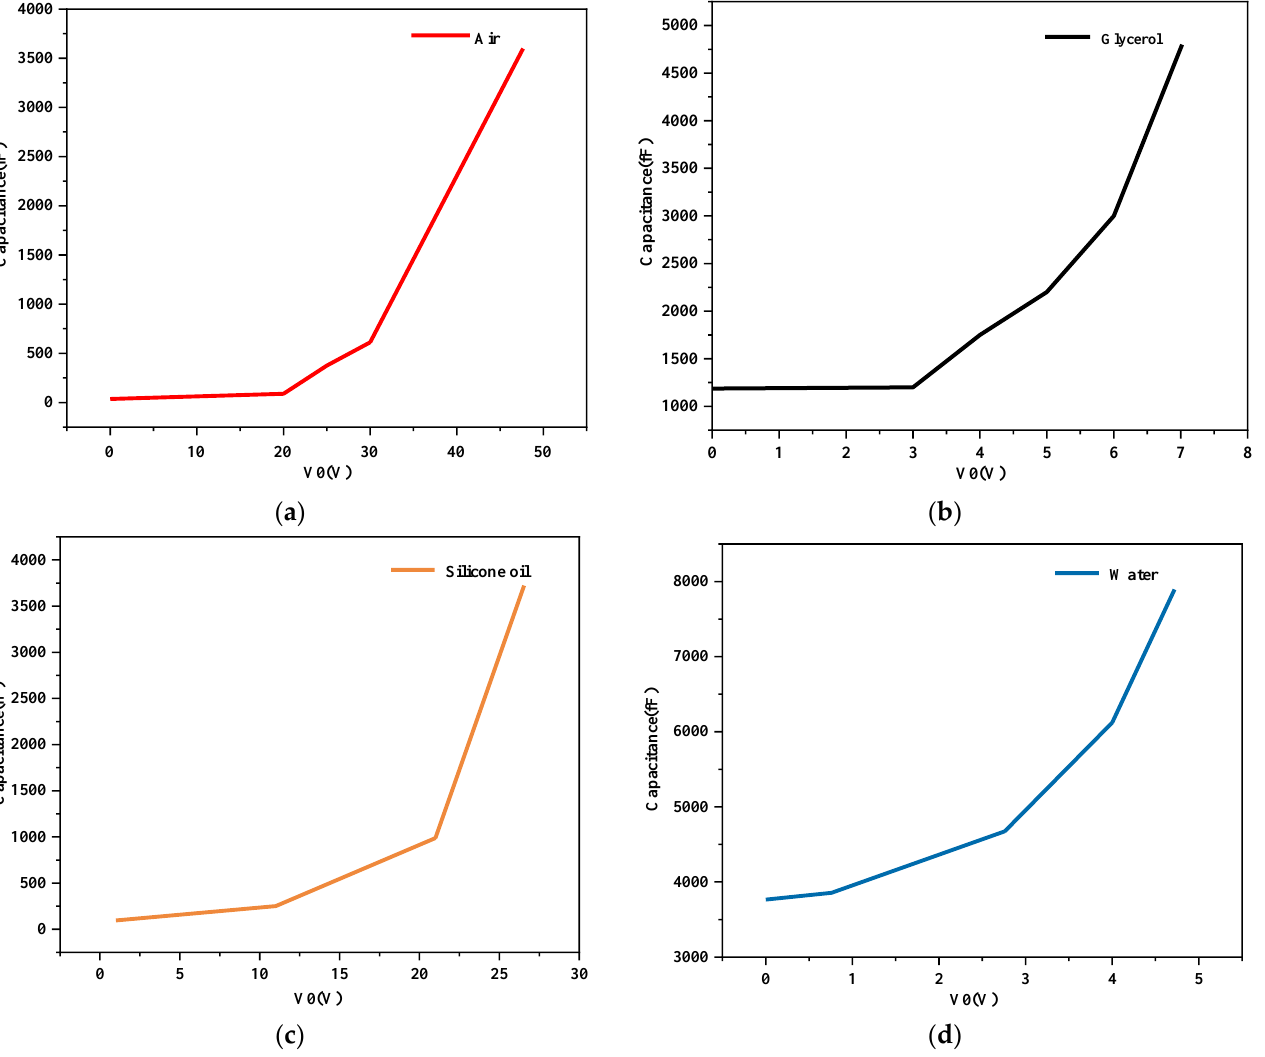
Figure 8. Changes in switch capacitance after RF MEMS switch was filled with different materials: ( a ) air; ( b ) glycerol; ( c ) silicone; ( d ) water.